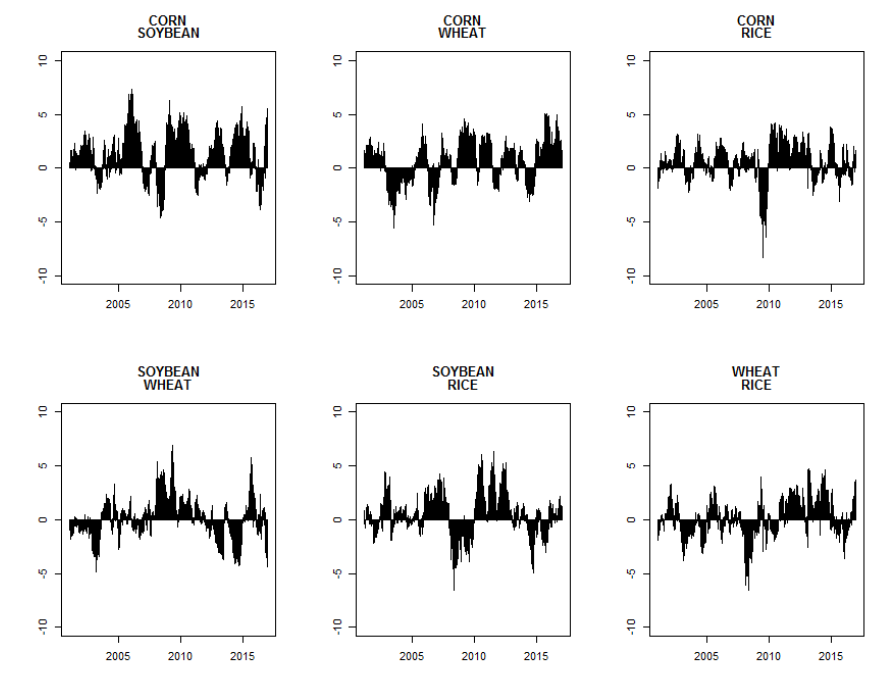
Figure 6A: Pairwise net volatility spillovers within the food markets (the OLS method)